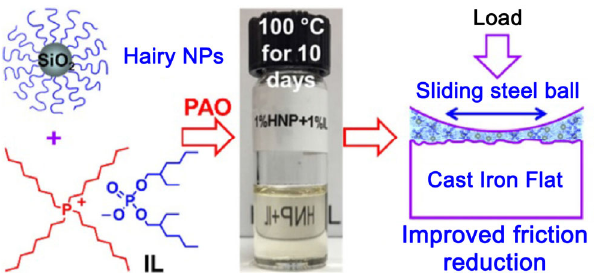
Fig. 16 The hairy NPs combined with IL as a friction-reducing additive in PAO. Reproduced with permission from Ref. [182]. © American Chemical Society,